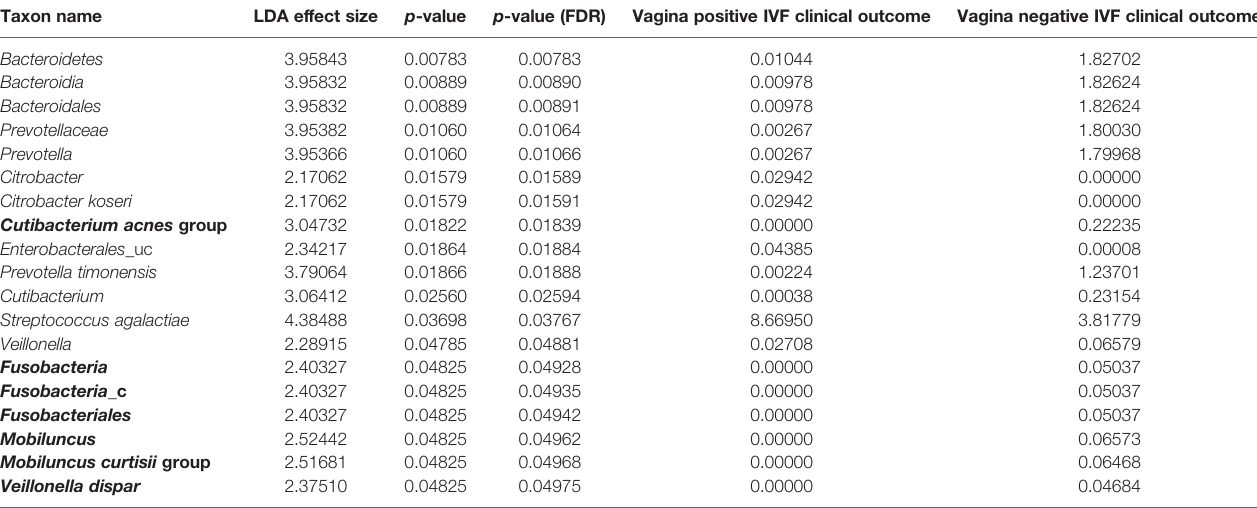
TABLE 3 | LefSe comparison of the taxonomic biomarkers in the vaginal swabs of women that had positive IVF clinical outcome and vaginal swabs of women with negative IVF clinical